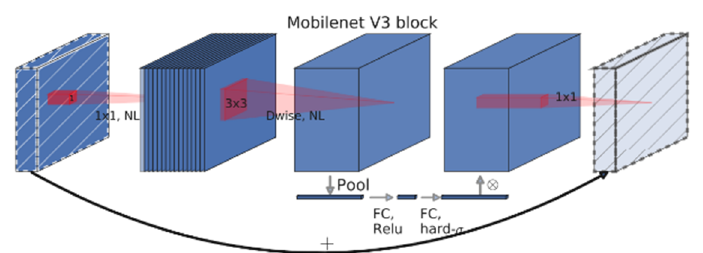
Figure 6. MobilenetV3-large network block structure.